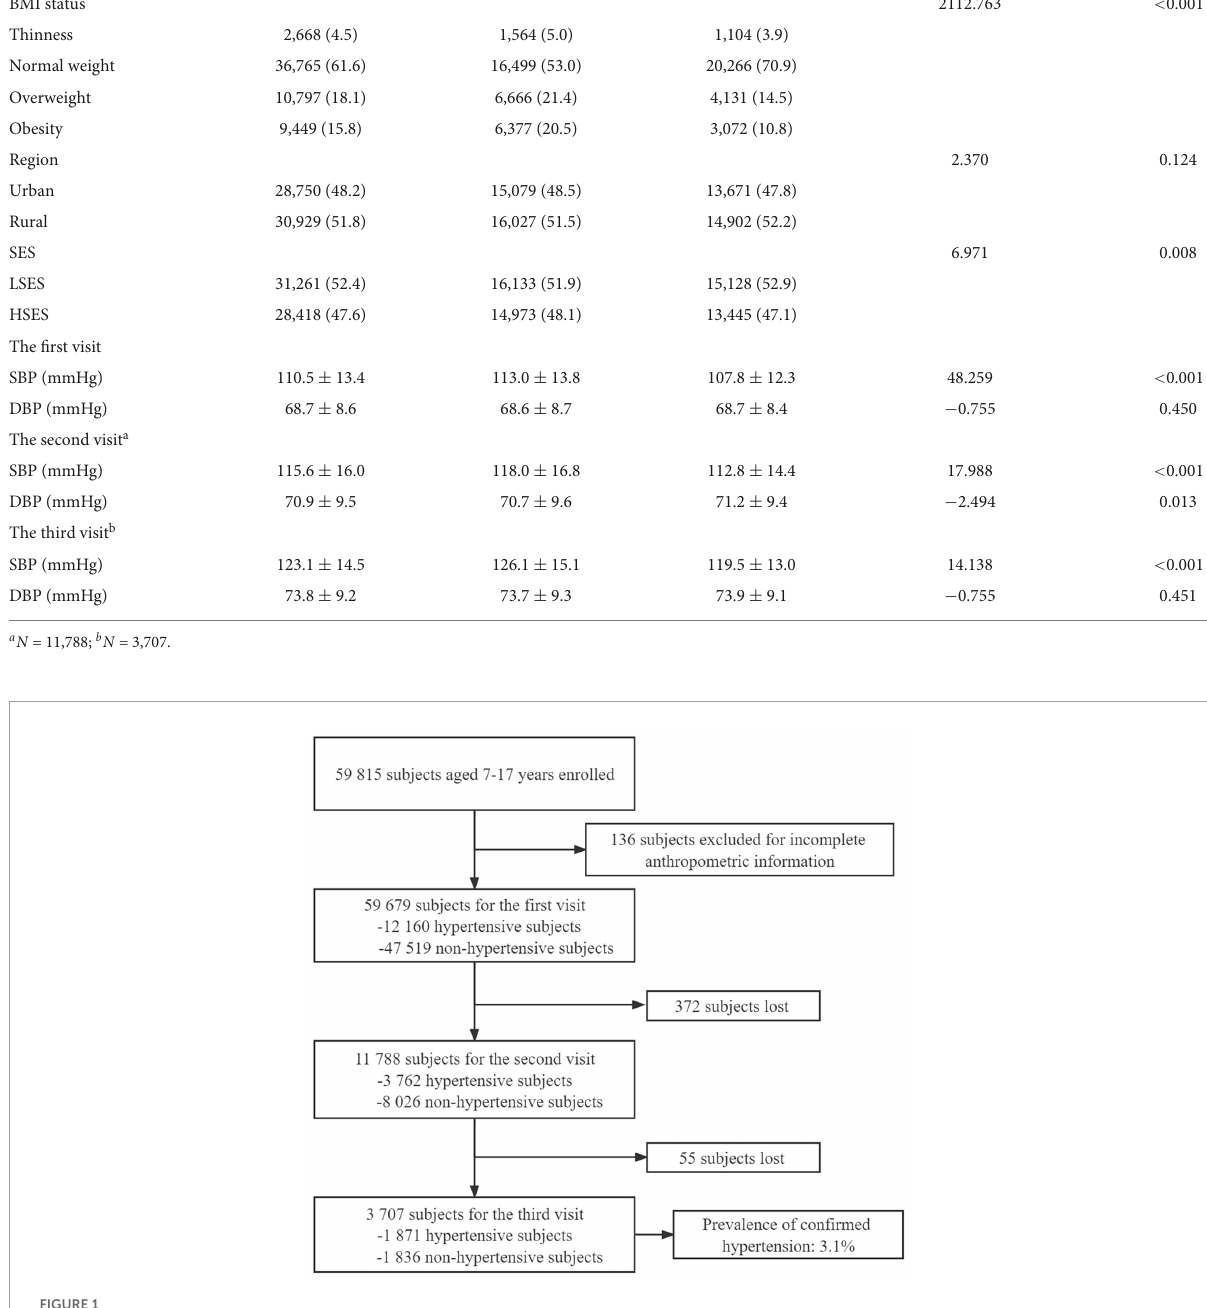
FIGURE1 The flowchart of blood pressure